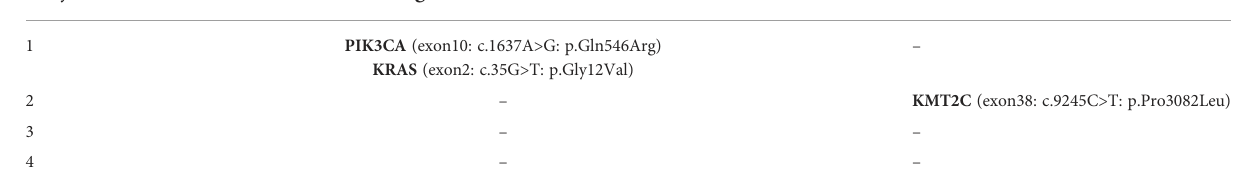
TABLE 6 Somatic mutations in patients with